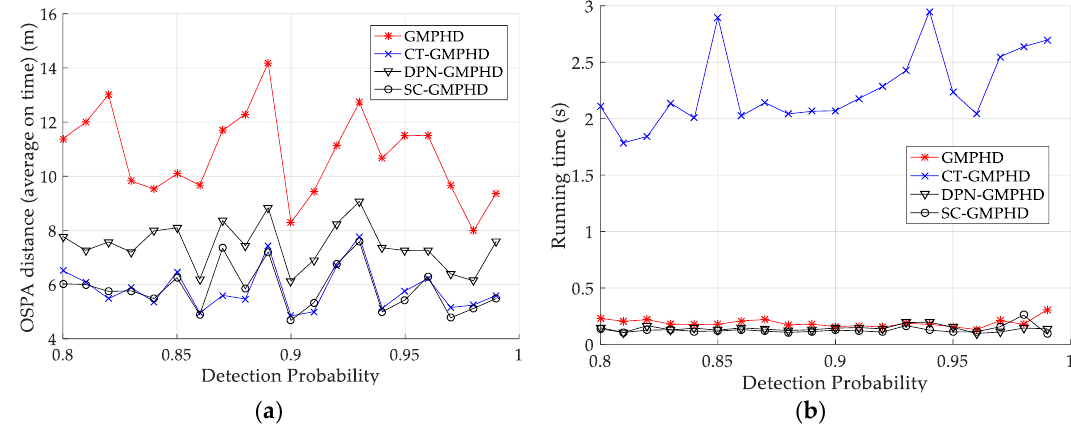
Figure 10. Comparison of tracking performance versus clutter rate for a target on a curved road: ( a ) average OSPA of the tracking algorithms; ( b ) running time of the tracking algorithms. Sensors 2018 , 18 , x FOR PEER REVIEW